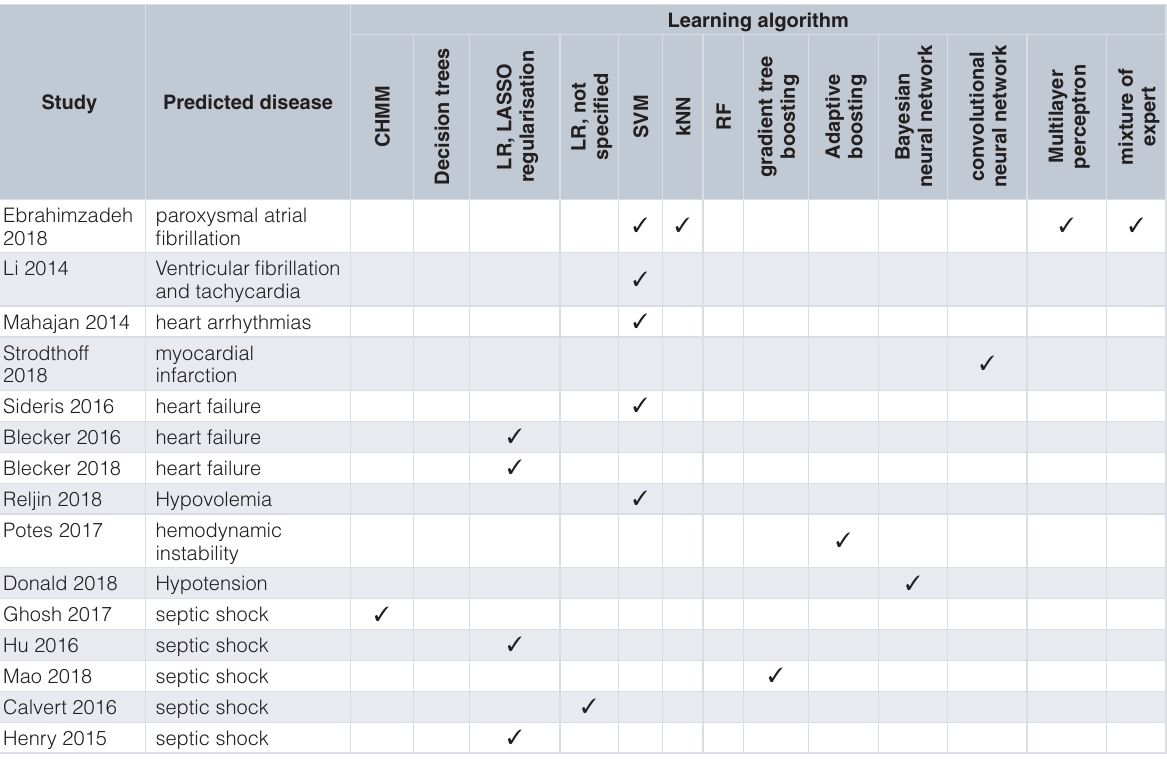
Table 3. Overview of the algorithms developed to detect